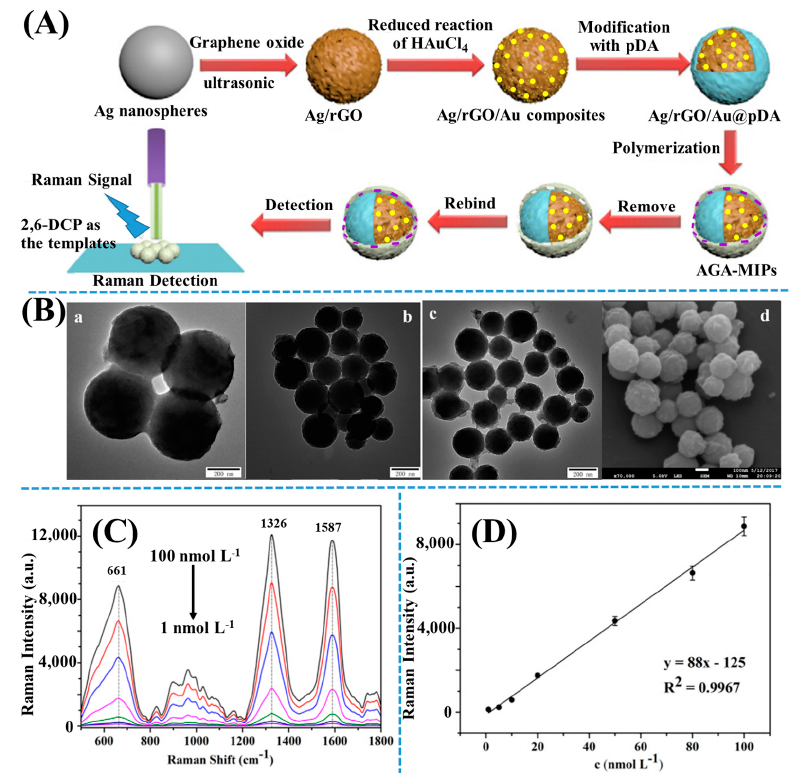
Figure 10. ( A ) Schematic diagram of trace detection of 2,6-DCP using Raman spectroscopy and MIPs based on nanocomposites of SiO 2 /rGO/Au. ( B ) TEM images of (a) SiO 2 /rGO, (b) composites of polydopamine modified SiO 2 /rGO/Au, (c) nanocomposites of SiO 2 /rGO/Au, and (d) SEM image of SiO 2 /rGO/Au nanocomposites. ( C ) Concentration-dependent Raman spectra of 2,6-DCP. ( D ) Linear curve of 2,6-DCP concentration-correlated Raman intensities at 661 cm − 1 . Adapted from [106].